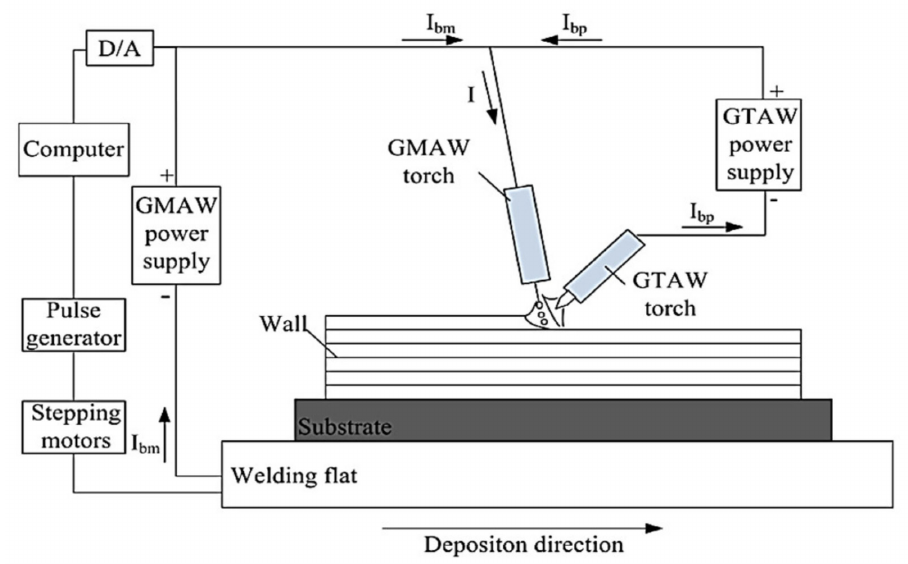
Figure 12. Schematic of double electrode GMAW based WAAM system. Reprinted with permission from Ref. [29]. Copyright 2016